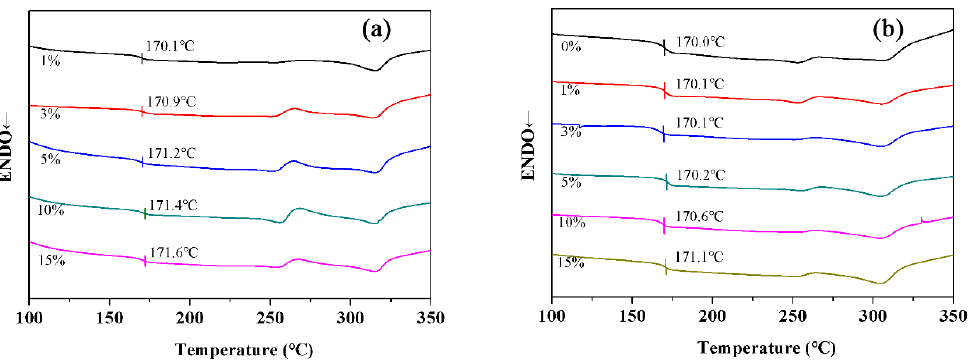
Figure 6. DSC curves of ( a ) BT@ZnPc-GO-1 / PEN films with 1, 3, 5, 10 and 15 wt % of BT@ZnPc-GO-1 and ( b ) BT@ZnPc-O-2 / PEN films with 1, 3, 5, 10 and 15 wt % of BT@ZnPc-GO-2.